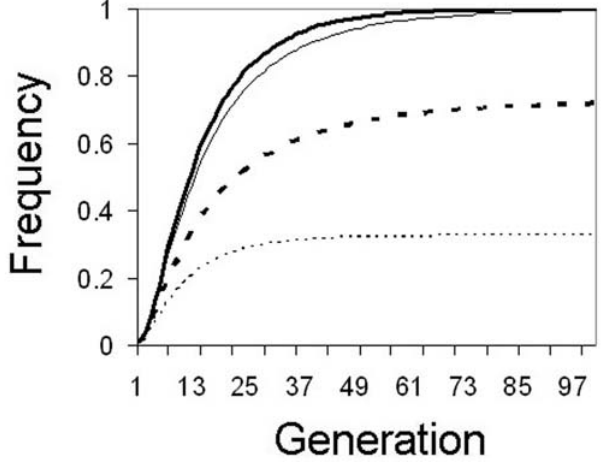
Figure 3. Continuous minimal release. Changes in transgene frequency with 1% continuous release rate per generation of mosquitoes homozygous for a transgene at 4 unlinked loci (8 copies/ genome). Thick solid line: no fitness cost ( F =1.0), thin solid line: 1% fitness cost/insert ( F =0.99), thick dotted line: 5% fitness cost/insert ( F =0.95), thin dotted line: 10% fitness cost/insert ( F =0.9).